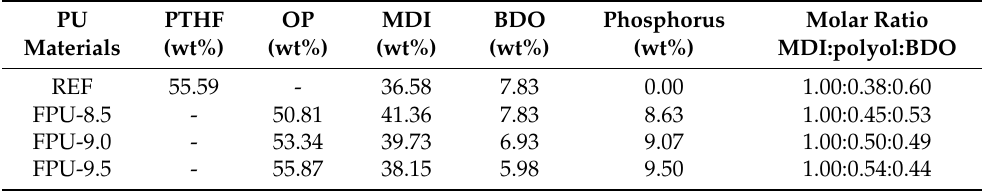
Table 1. The formulations of synthesized